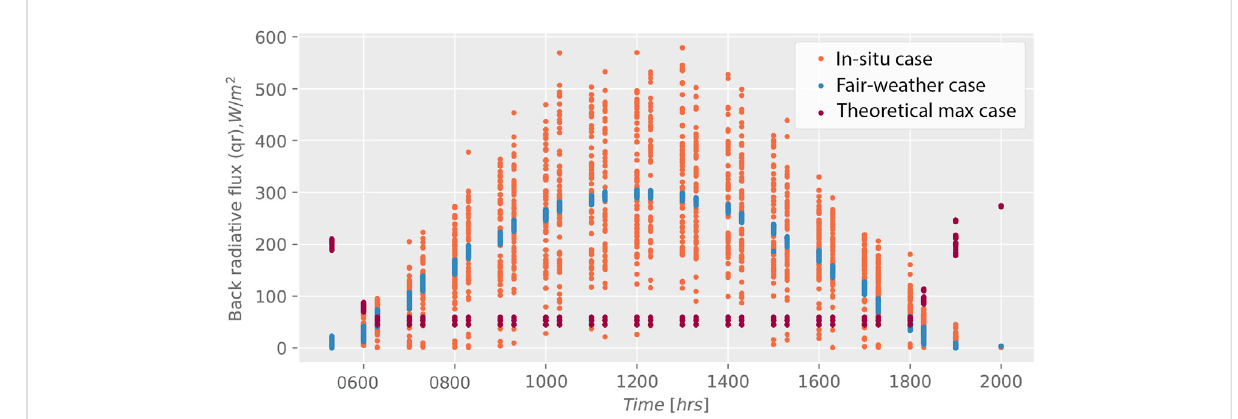
FIGURE 4 Graphical representation of half hourly back-side radiative fl ux (qr) for 15th June-15th August.